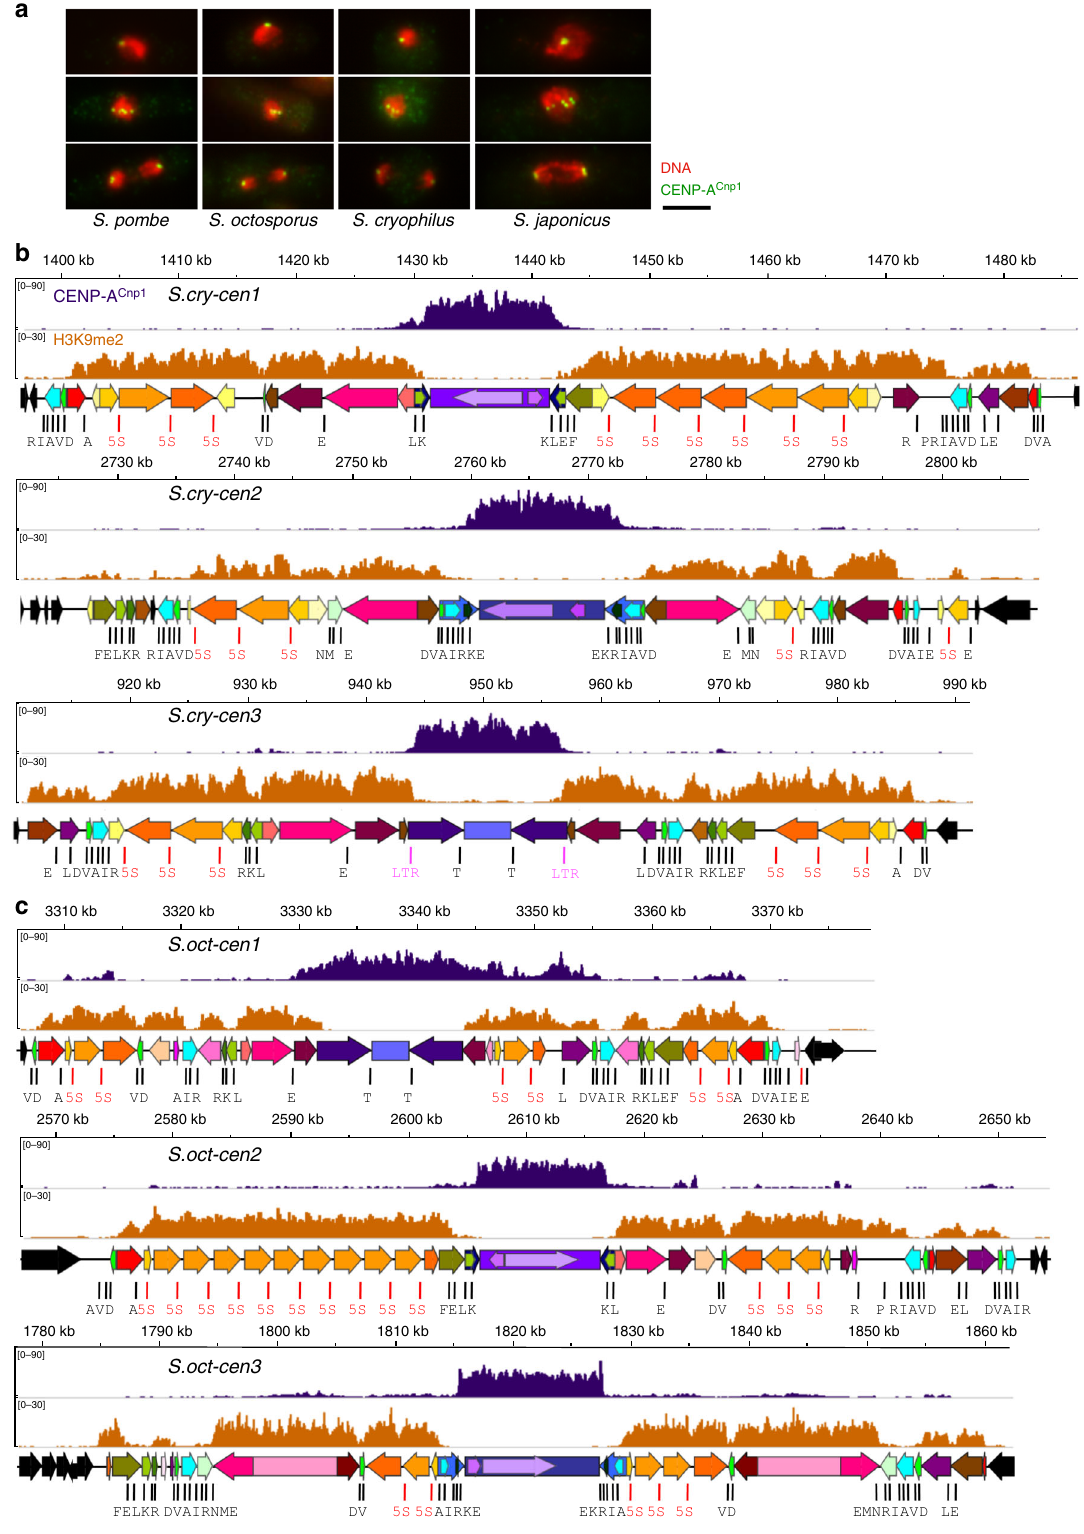
short (oCNT-S(1.2 kb); cCNT-S(1.3 kb)) species-speci fi c repeats (Fig. 3f, Supplementary Tables 1, 2, 9 and Supplementary Data 3, 4). CNT repeats are arranged head-to-tail at one centromere and head-to-head at the other centromere in each